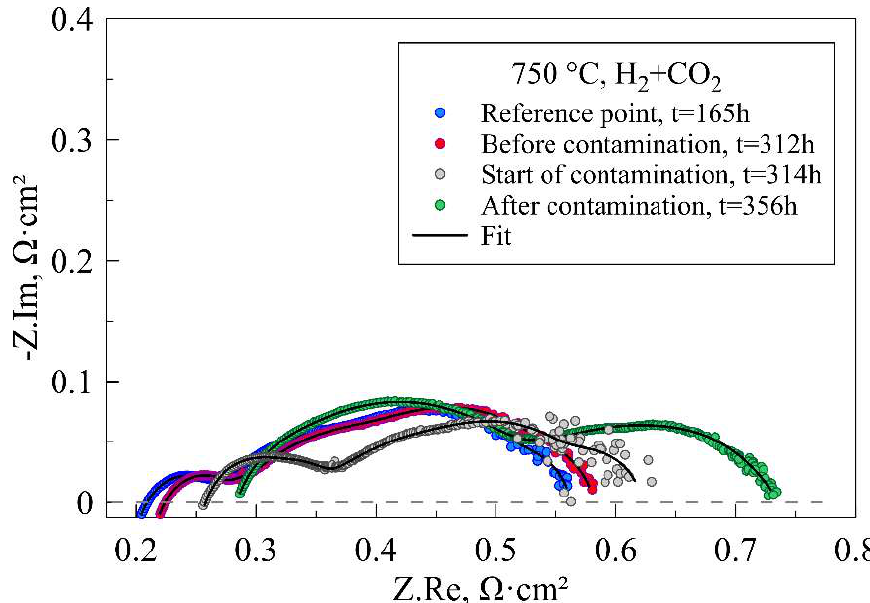
Figure 10. Evolution of EIS spectra. Measurement at 314 h corresponds to fly ash aerosol contamination with 100 Nml/min CO 2 flow through generator; other spectra were collected using 20% of H 2 in CO 2 1000 Nml/min fuel flow.